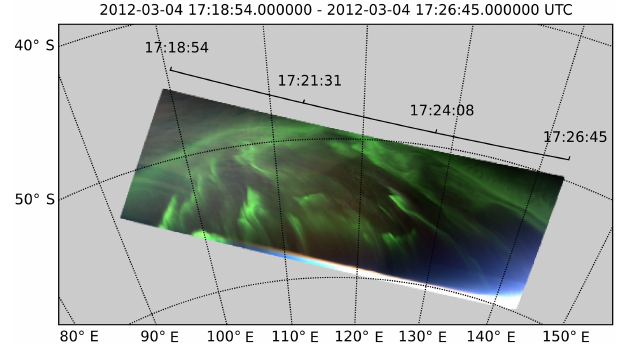
Figure 13. An example “scan line” summary plot that is made avail- able online for each image